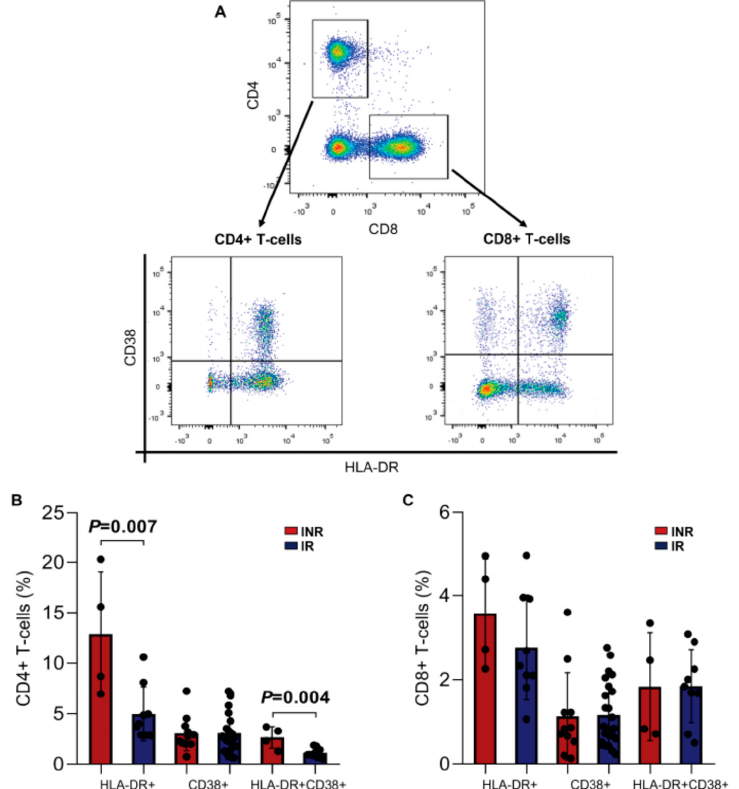
Figure 5. Immune activation of CD4+ and CD8+ T cells in the INR and IR groups. (A) Representative dot plots showing the gating strategy for activated CD4+ (CD4+/CD38+ and/or HLA-DR+) and CD8+ (CD8+/CD38+ and/or HLA-DR+) T-lymphocytes. (B) Percentage of HLA-DR+, CD38+, and both in CD4+ T cells. (C) Percentage of HLA-DR+, CD38+, and both in CD8+ T cells. Means, standard deviation, and p -values (according to the t-test) are shown. INR—immunological non-responders. IR—immunological responders.